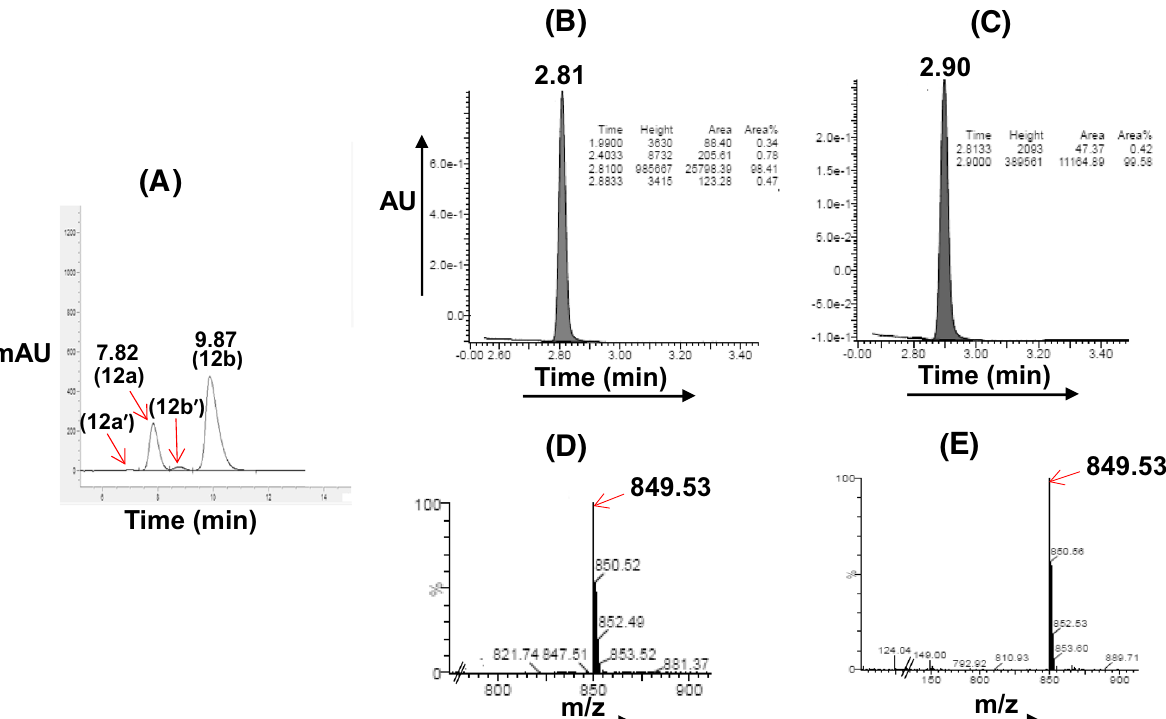
Figure 3. HPLC ( A ) chromatogram of a mixture of isomers of IVM-CQ 12 . UPLC chromatograms of isomers ( B : 12a ; C : 12b ) after separation. UPLC-MS chromatograms: ( D ) 12a and ( E ) 12b